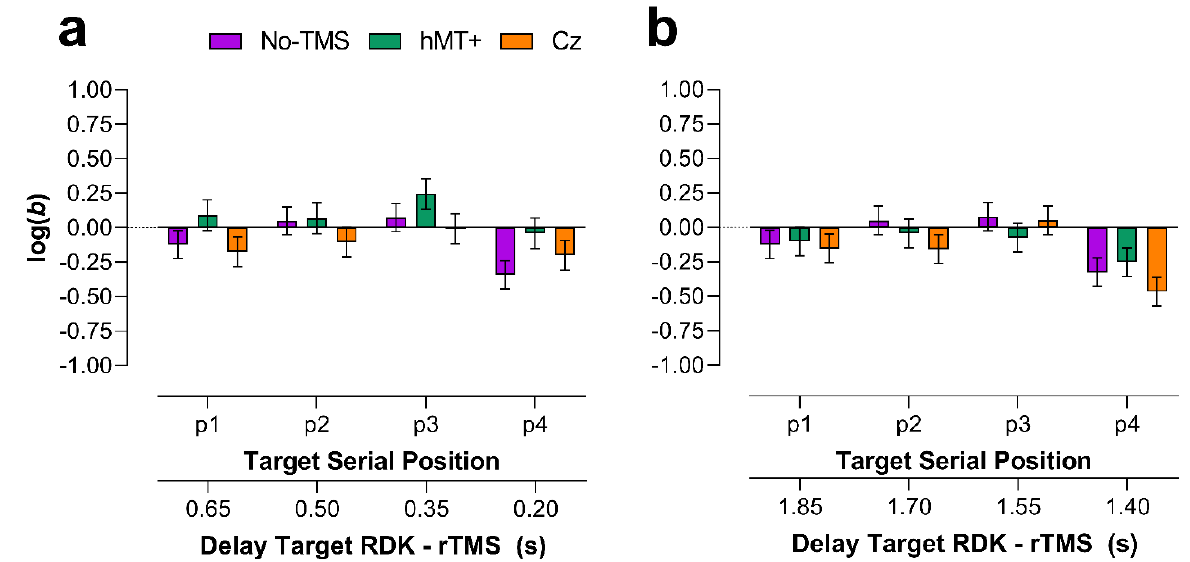
Figure 3. Mean bias [ log ( b )] for each serial position of the target RDK (1 to 4) and each TMS condition. The plotted data and error bars were estimates from the output of the selected and fitted GLMM models for early and late rTMS. Data are symmetrical with respect to zero, with negative values indicating a bias towards yes responses, and positive values towards no responses. The secondary x-axes indicate the time delay (in seconds) between the offset of each RDK in the motion sequence and the onset of the TMS. ( a ) log ( b ) values estimated for early rTMS. ( b ) log ( b ) values estimated for late rTMS. Error bars ±SEM.